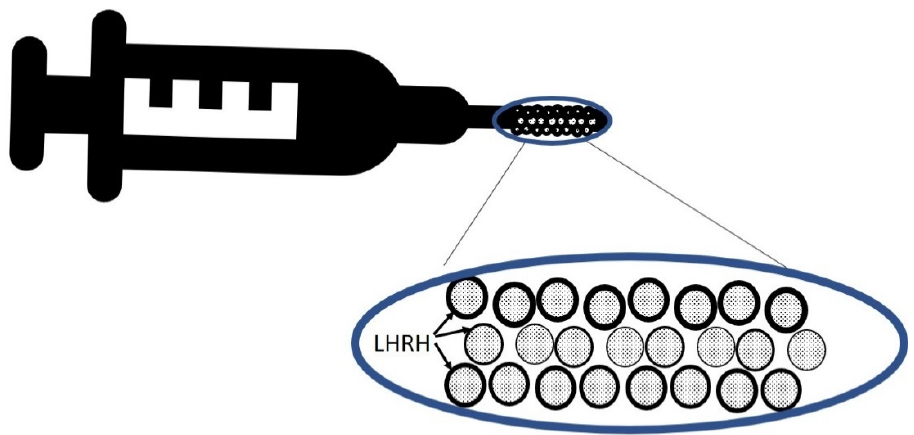
Figure 6. Short-acting LHRH agonists enveloped in dissolvable capsules of varying thickness to allow for cyclic release of LHRH to the circulation. allow for cyclic release of LHRH to the